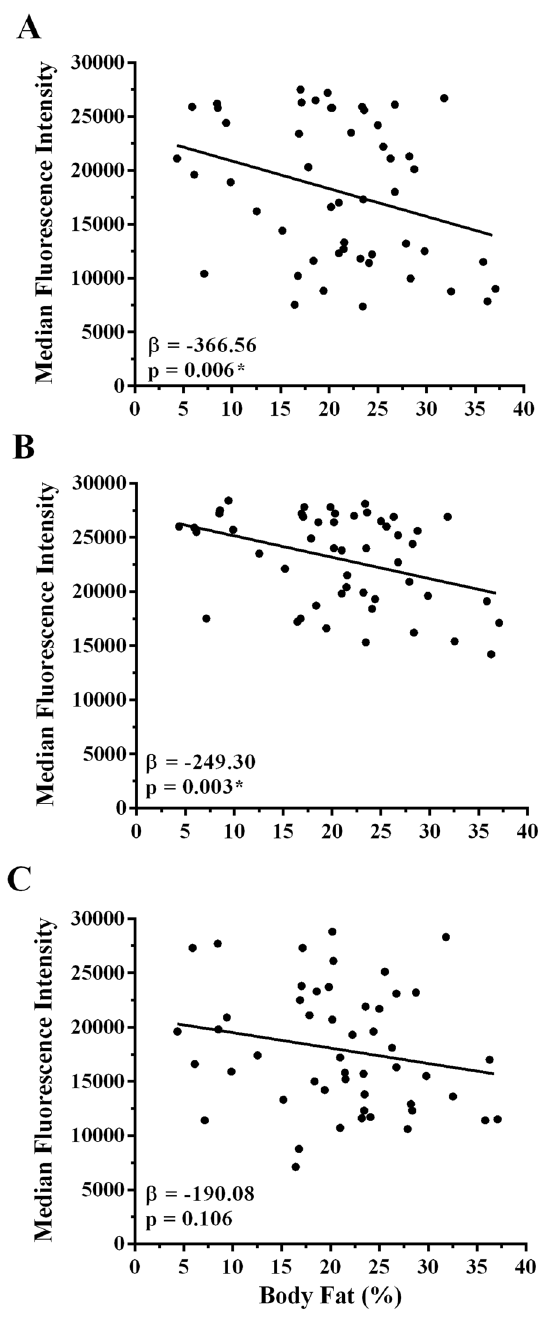
Figure 3. Effect of body fat on viral protein-specific serum antibody levels in response to SARS-CoV-2 mRNA vaccination after accounting for the known effects of age, time since vaccination and the type of mRNA vaccine (Pfizer or Moderna) received. Spike protein subunit 1 ( A ), receptor binding domain protein ( B ), and spike protein subunit 2 ( C ) (N = 50). *Denotes statistical significance p <